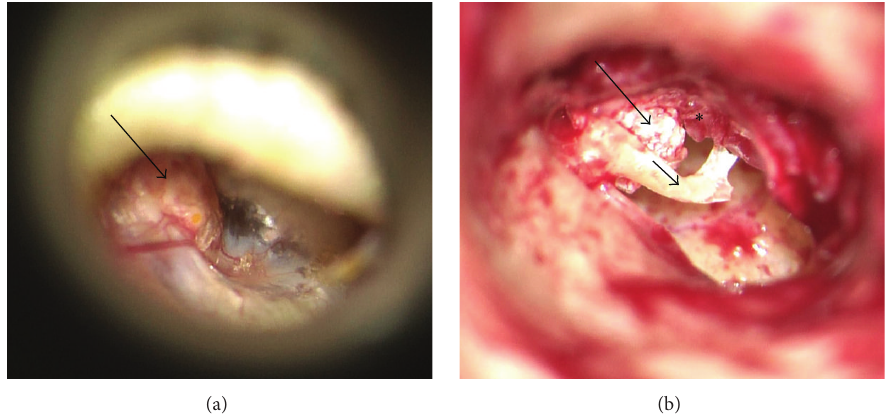
Figure1:(a)Viewoftherighttympanicmembraneandlesion(arrow)utilizingtheoperatingmicroscope.(b)Intraoperativeviewofthelesion (longarrow)withintheliftedtympanicmembrane(asterisk)andtheunderlyingmalleus(shortarrow)(imagescourtesyofDr.AbrahamJacob, MD).